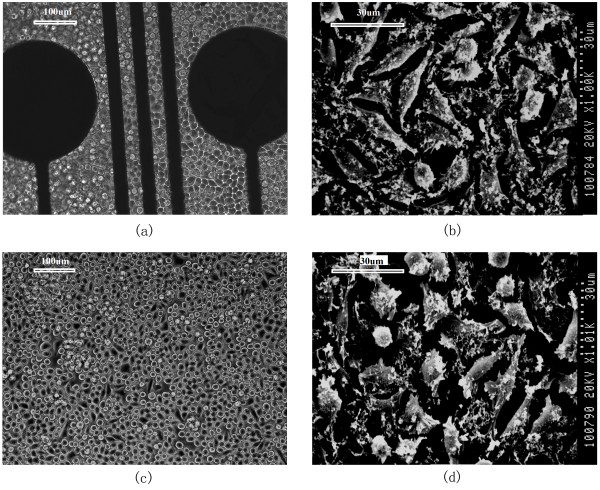
Morphology of the L929 cells growing directly on the microelectrode. (a and b) Cells were photographed with an inverted light microscope (× 200) or by scanning electron microscopy, respectively after 3 days in culture. (c and d) Control cultures under the same conditions.